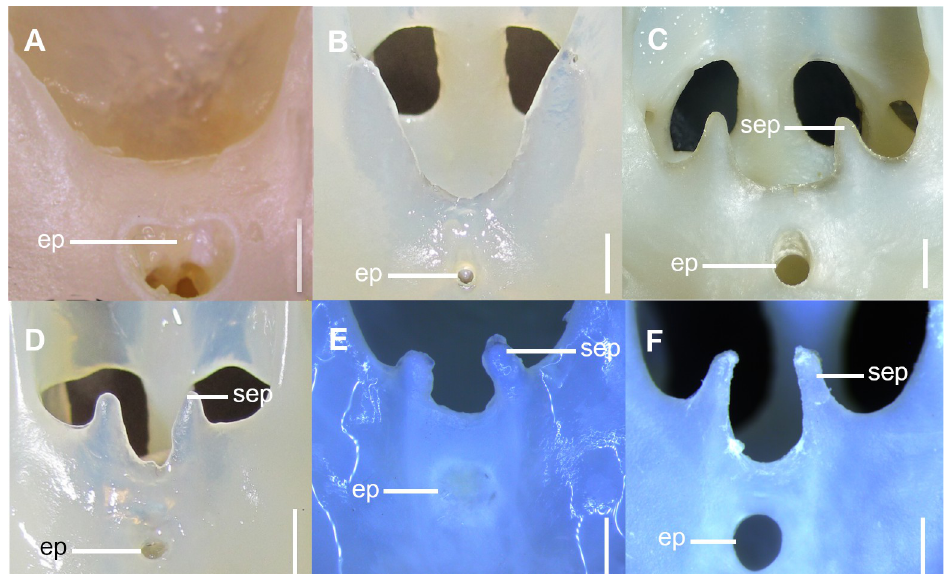
Fig 3. Detail of ethmoidal region of the neurocranium in anterior dorsal view. A: C . australis , CSIRO H7042-04, juvenile female, 605 mm TL; B: C . asper , SAM 38269, adult female, 1045 mm TL; C: C . asper , UFPB 11864, juvenile female, 970 mm TL; D: S . suckleyi , SAM 38346, adult female, 850 mm TL; E: S . albifrons , MZUSP 121272, adult male, 760 mm TL; F: S . montalbani , MZUSP121270, adult male, 713 mm TL. Abbreviations: ep: epiphyseal pit; sep: supraethmoidal process. Scale bars: 2mm (A,E,F), 5mm